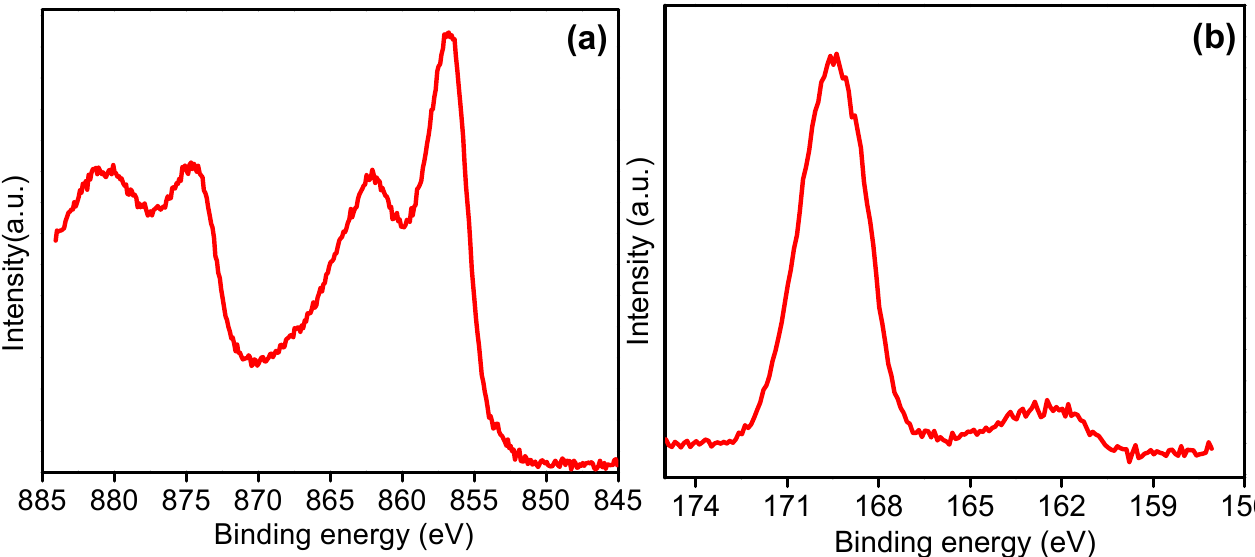
Figure 4. ( a ) Ni 2p XPS high-resolution spectra and ( b ) S 2p high-resolution spectra of the w-NiS-3D-Nf electrode.